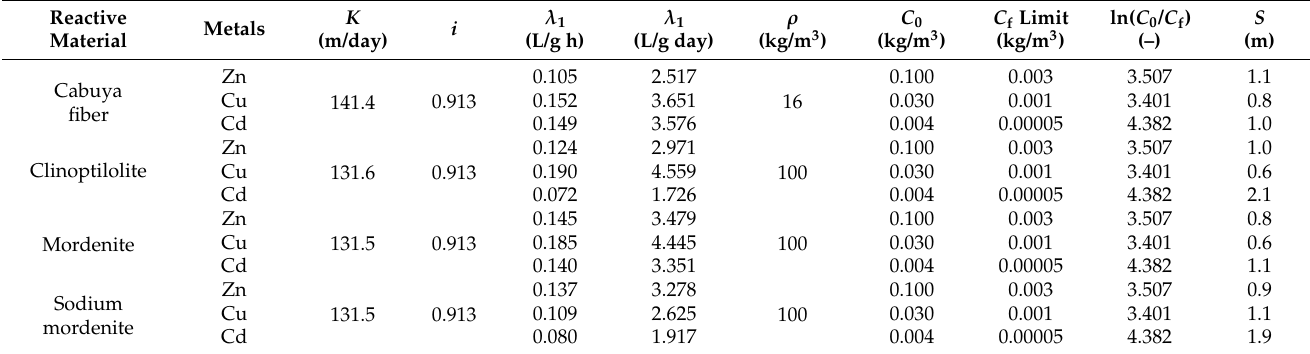
Table 7. Summary table of the hydraulic conductivity ( k ) values, piezometric gradient ( i ), first-order ( λ 1 ) degradation kinetics constant, bulk density ( ρ ), initial concentration ( C 0 ), final concentration ( C f ) which is the objective of the reclamation and thickness ( S ) of the PRB.